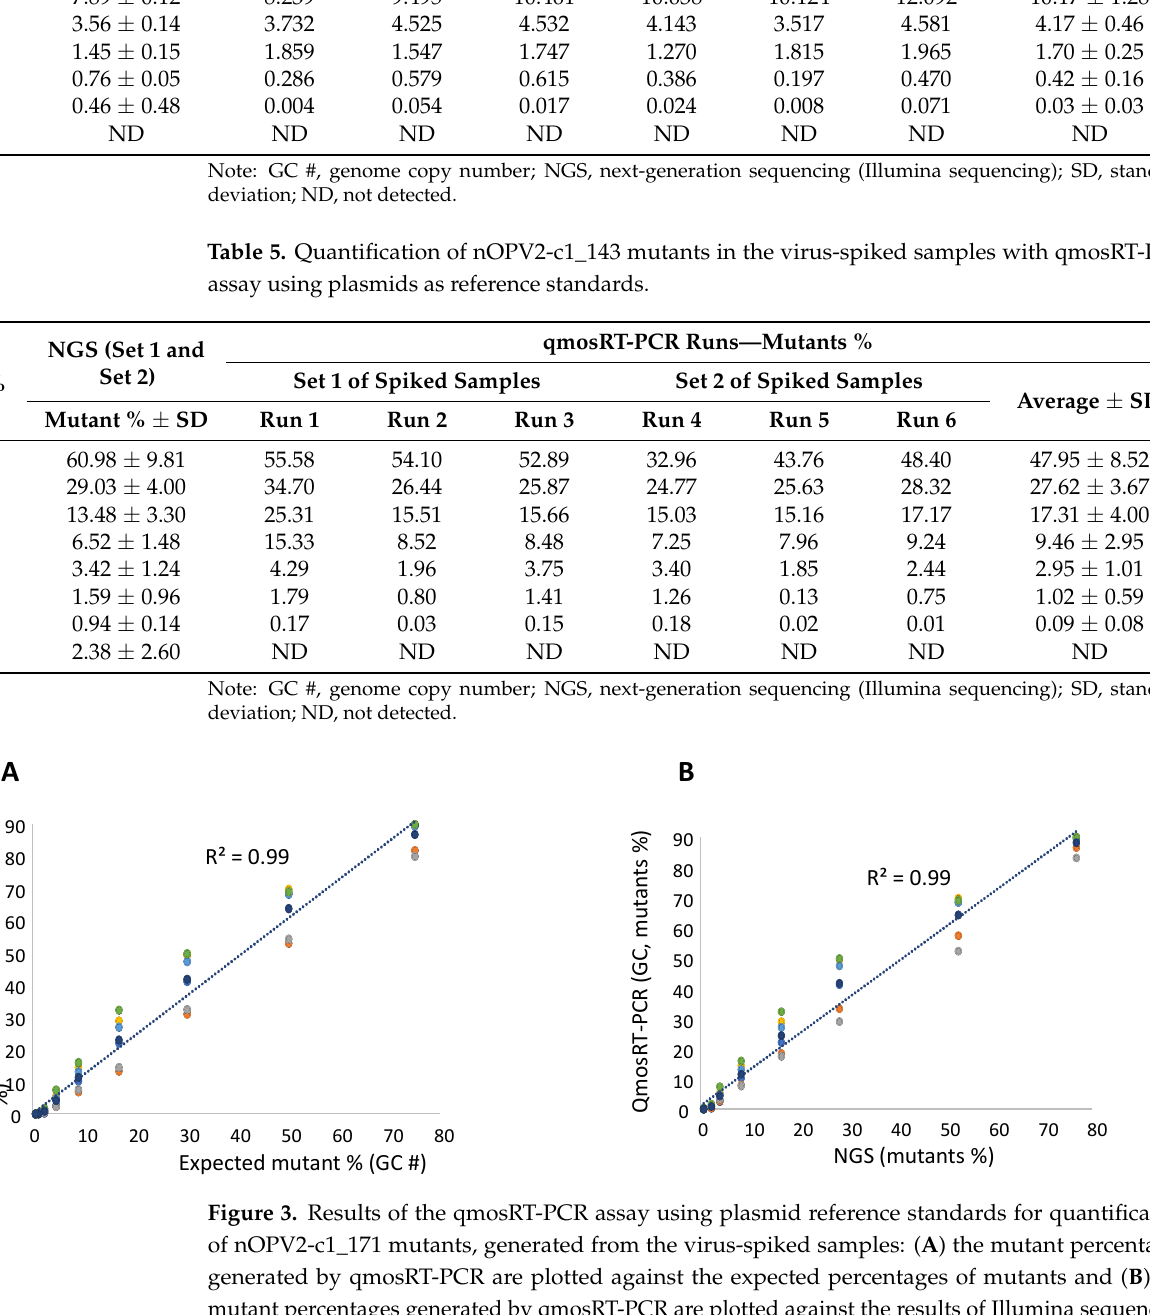
Table 3. Quantification of nOPV2-c1_171 mutants in the virus-spiked samples by qmosRT-PCR assay using plasmids as reference standards.